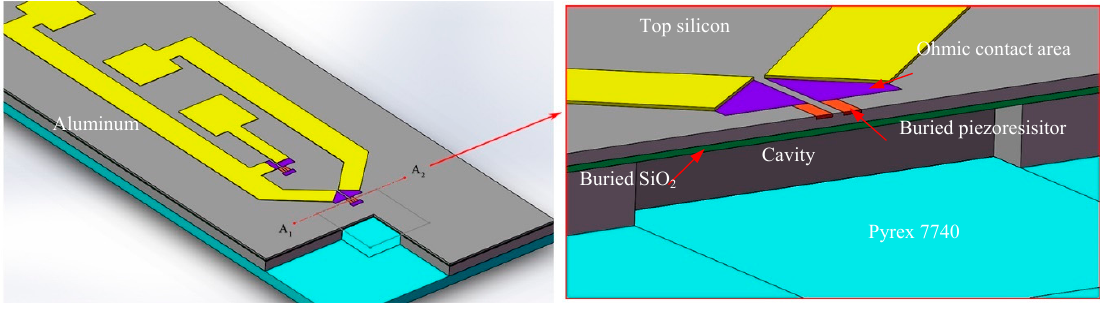
Figure 1. Sketch of the proposed pressure sensor.